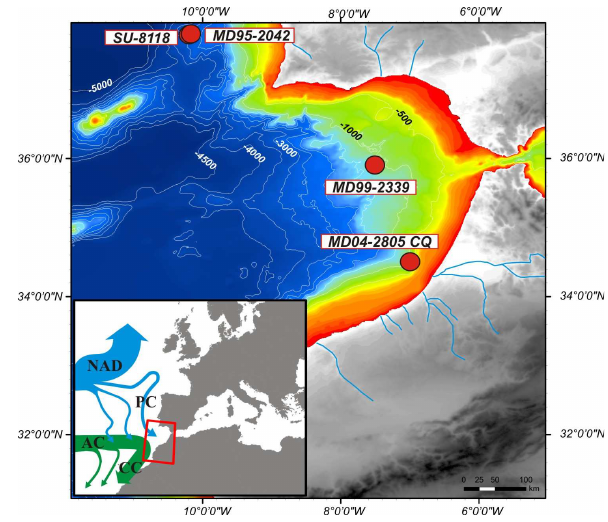
Fig. 1. Major sea-surface currents in the study area (small map): Figure1 1335 North Atlantic Drift (NAD), Portugal Current (PC) flowing south- ward from 45 ◦ N to 30 ◦ N, Azores Current (AC) derived from the southern branch of the Gulf Stream and flowing eastward to the Gulf of Cadiz at about 35 ◦ N, and Canary Current (CC) fed by both the AC and the PC. Together, these currents form the Eastern Boundary Current system of the North Atlantic subtropical gyre. The stud- ied cores MD99-2339 (35.89 ◦ N; 7.53 ◦ W; 1170m water depth), MD04-2805 CQ (34.52 ◦ N; 7.02 ◦ W; 859m water depth), and SU- 8118 (37.78 ◦ N; 10.18 ◦ W; 3155m water depth), as well as MD95- 2042 (37.80 ◦ N; 10.17 ◦ W; 3146m water depth), are located on the bigger map, depicting also the bathymetry of the study